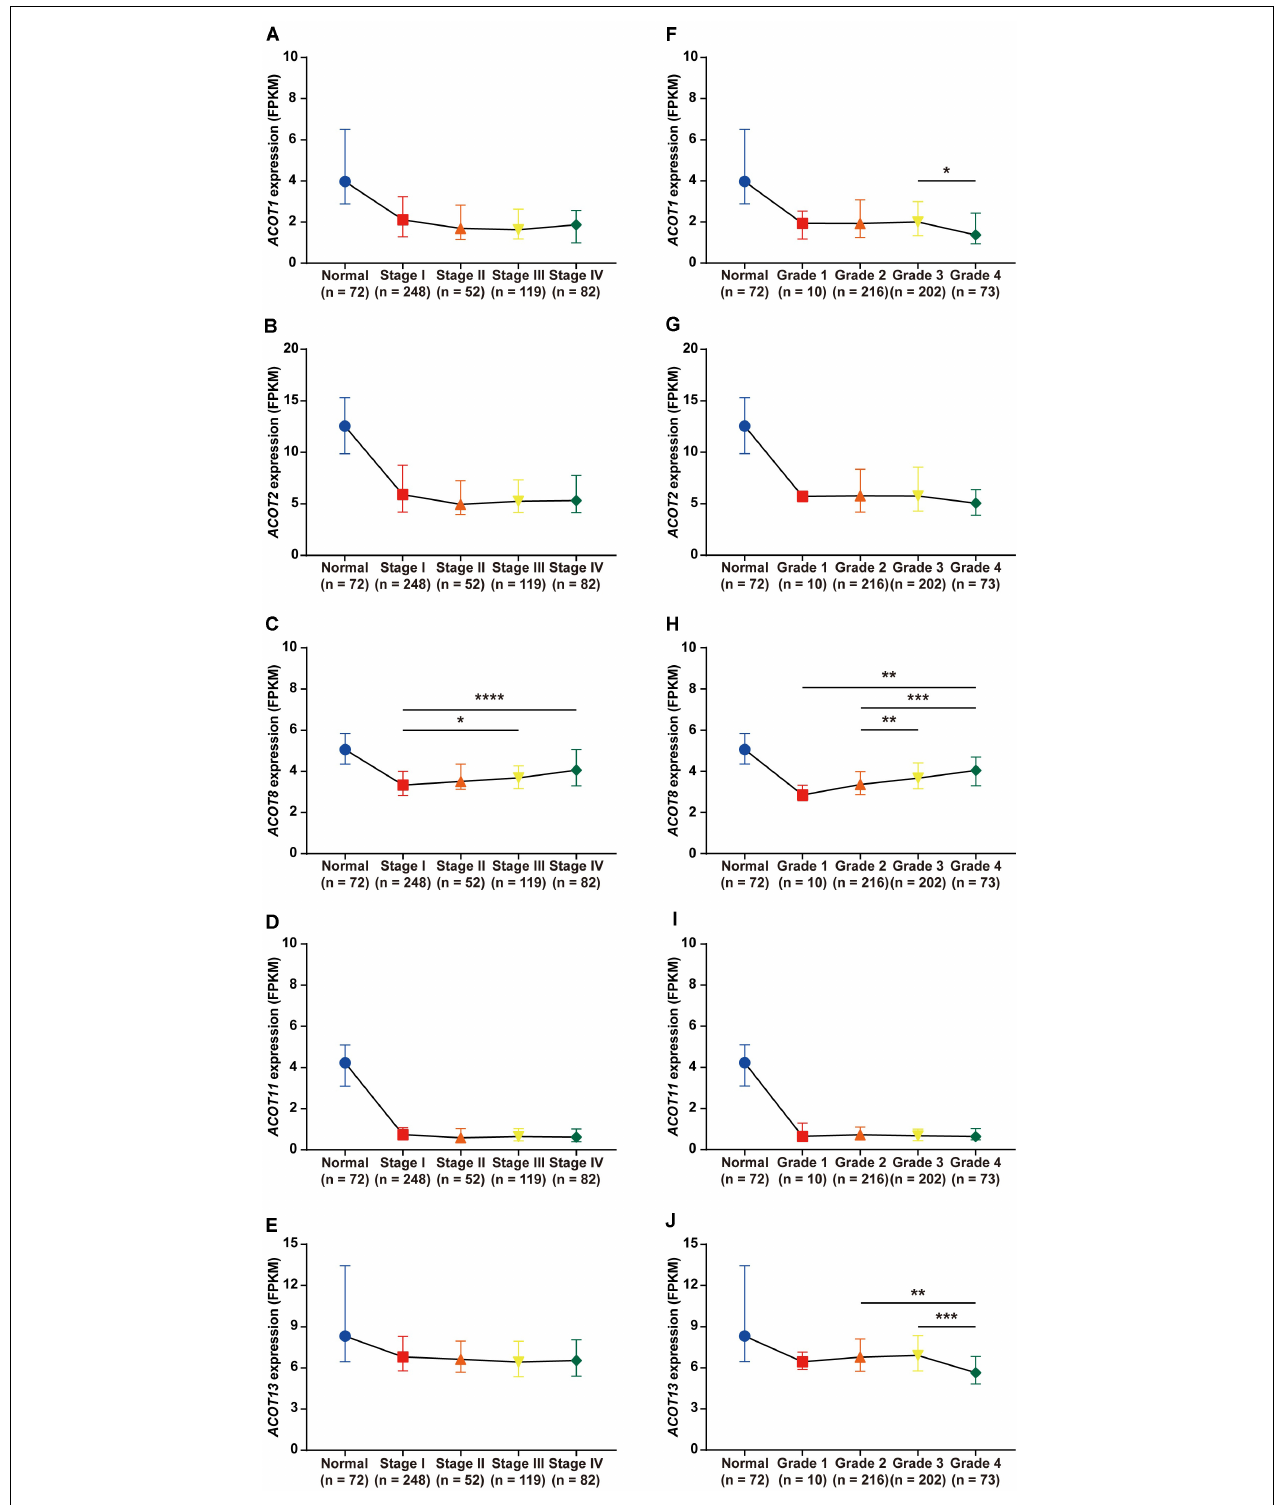
FIGURE 4 | Relation between different ACOTs expressions and disease progression in ccRCC patients. ccRCC and normal kidney samples with complete clinical data were utilized to analyze the relationship between mRNA expressions of ACOTs and TNM stages (A–E) as well as histological grades (F–J) . There was no obvious correlation between ACOT1/2/11/13 expressions and tumor progression, while ACOT8 was continuously upregulated with tumor progression. * p < 0.05, ** p < 0.01, *** p < 0.001, **** p < 0.0001.